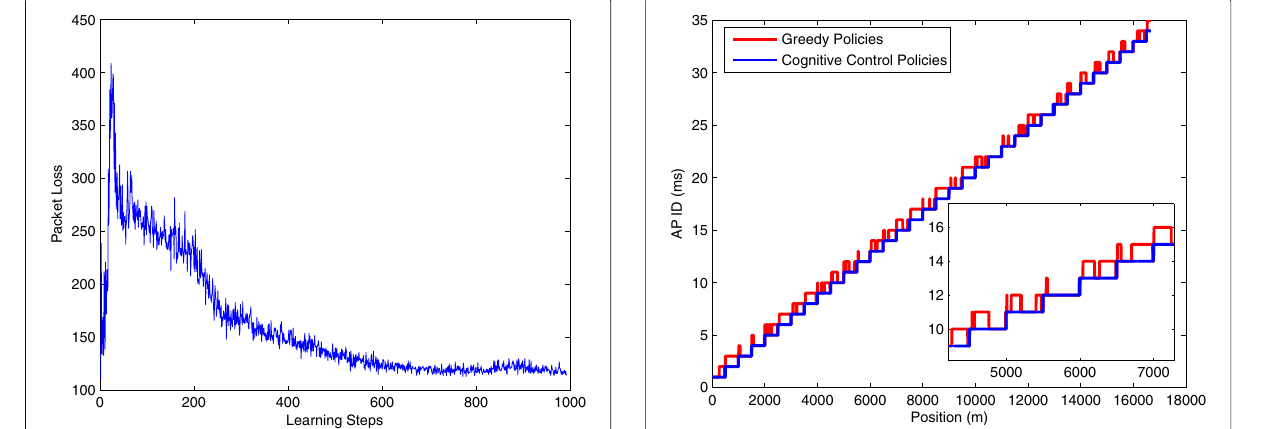
SNR level, which is based on the reinforcement learning.